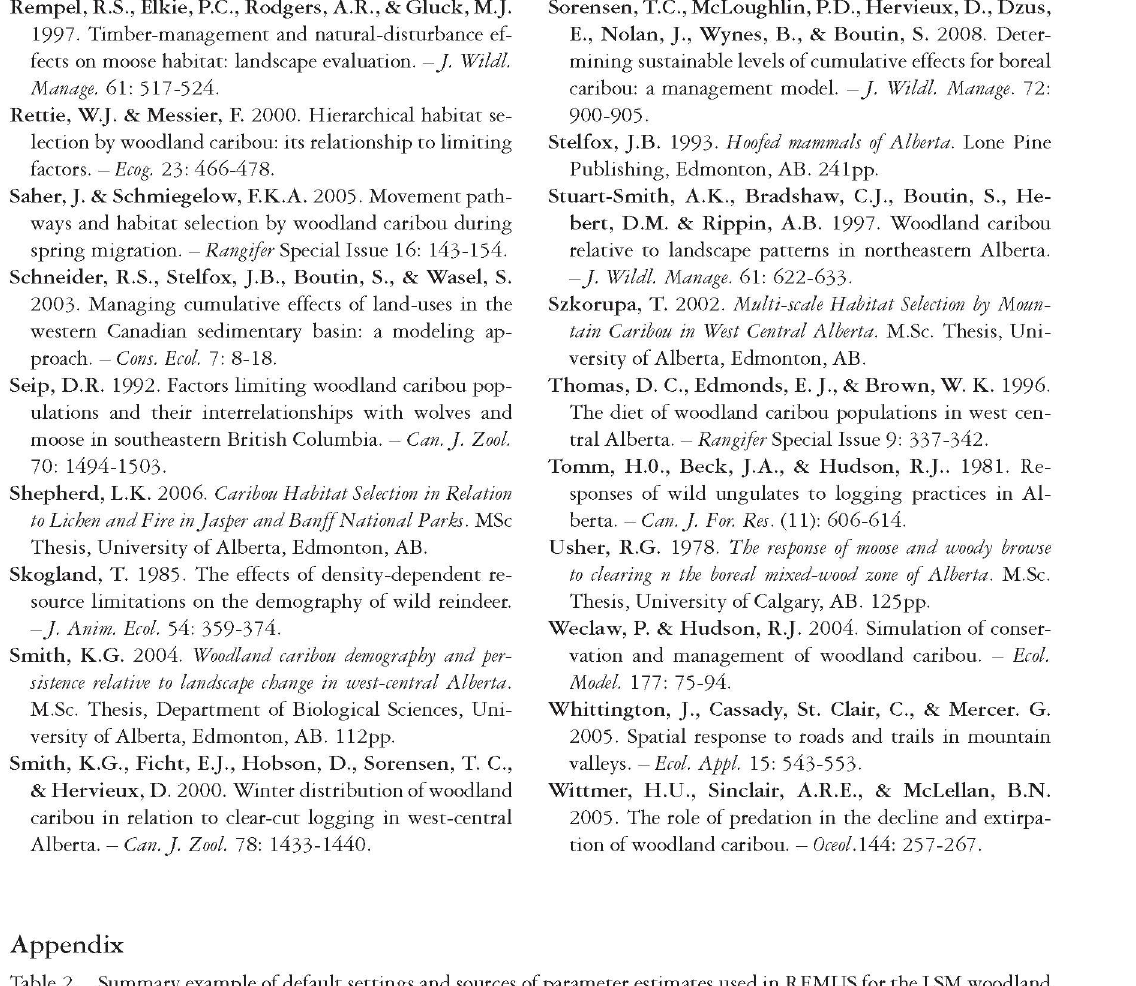
Table 2. Summary example of default settings and sources of parameter estimates used in REMUS for the LSM woodland caribou herd in west central